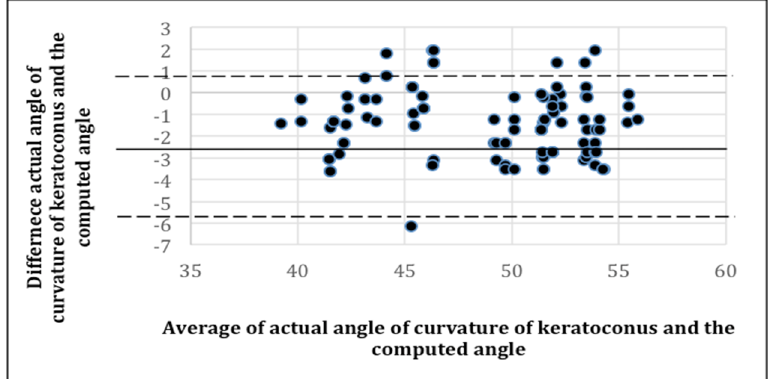
Figure 11. Bland-Altman plot.